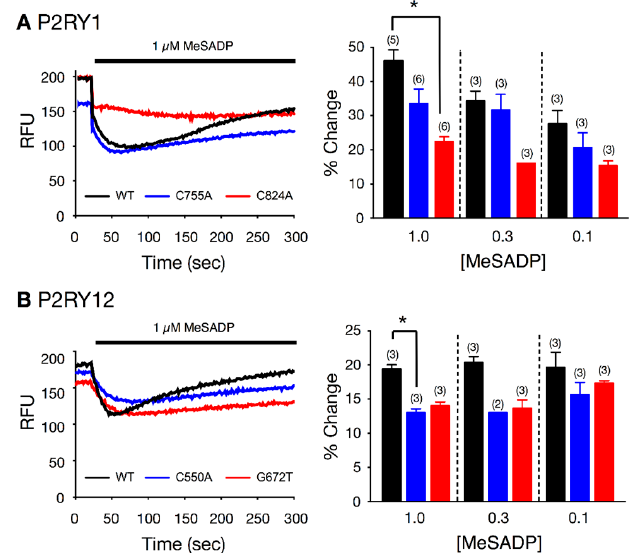
Figure 2. Effect of MeSADP-stimulated fluorescence changes in L cells heterologously expressing P2RY1 ( A ) and P2RY12 ( B ) wild type and variant receptors. The left panel ( A ) shows sample fluorescence signals (raw fluorescence units, RFU) from L cells transfected with wild type (black trace), C755A (blue), and C824A (red) P2RY1 cDNA constructs, before and during MeSADP (1 µ M solid line) application. Left panel ( B ) depicts the fluorescence signals (RFU) in cells expressing wild type (black trace), C550A (blue trace) and G672T P2RY12 receptors. Panels on the right ( A , B ) are summary plots showing the mean (+SEM) changes of fluorescence signals following MeSADP application. * p < 0.05 employing ANOVA.